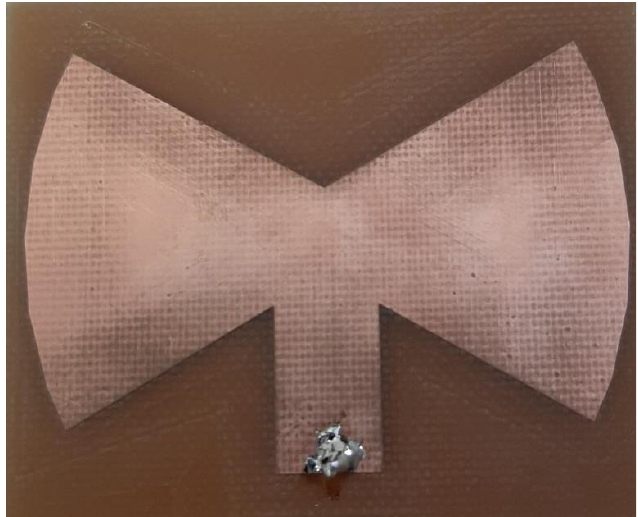
Figure 13. Fabricated bow-tie microstrip patch